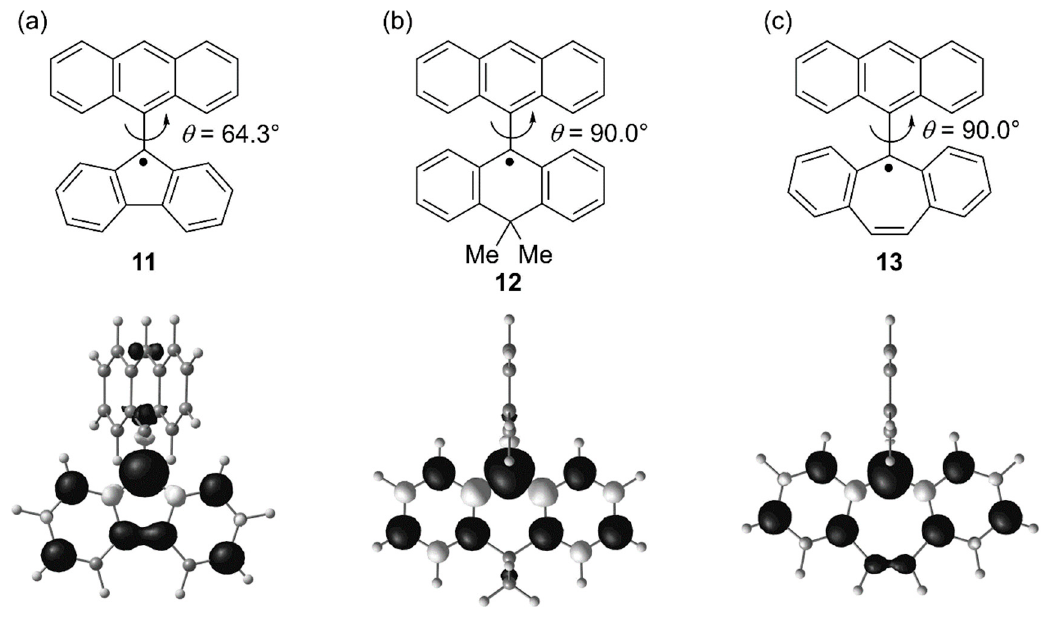
Figure 12. Anthryl-substituted tricyclic radicals ( 11 ( a ), 12 ( b ), and 13 ( c )). Spin density maps calculated by UBLYP/6-31G**//U ω B97X-D/6-31G** are also shown. Table 2. Redox potentials (V vs Fc/Fc + ) of 11 , 12 , and 13 .